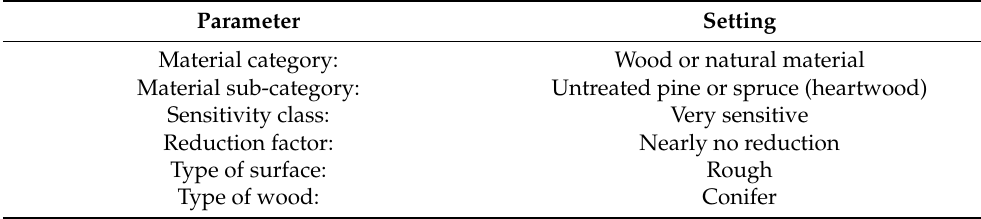
Table 2. Parameters for the WUFI VTT